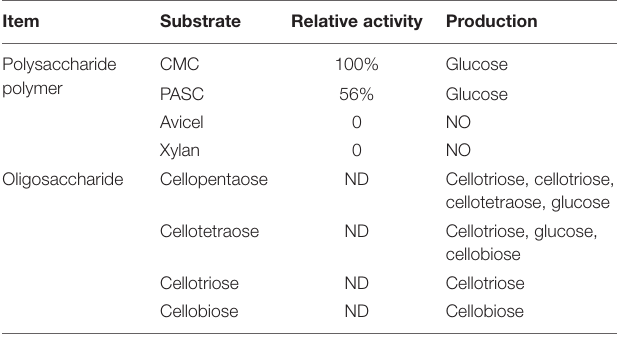
TABLE 1 | The substrate specificity of recombinant